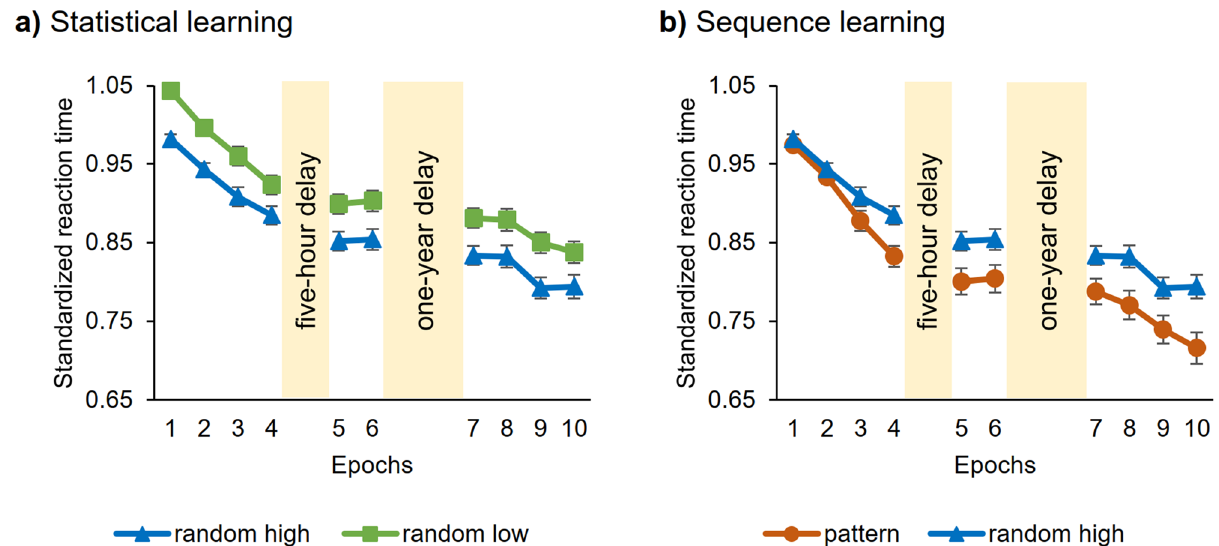
Figure 2. Temporal dynamics of ( a ) statistical and ( b ) sequence learning across epochs and sessions. Standardized RT values as a function of the epoch (1–10) and trial types (random high vs random low for statistical learning and pattern vs random high for sequence learning) are presented. Blue lines with triangle symbols indicate standardized RT values on the random high trials, green lines with square symbols indicate standardized RT values on the random low trials and orange lines with circle symbols indicate standardized RT values on the pattern trials. ( a ) Statistical learning is quantified by the gap between blue and green lines and ( b ) sequence learning is quantified by the gap between orange and blue lines. In both cases, greater gap between the lines represents better learning. Error bars denote standard error of